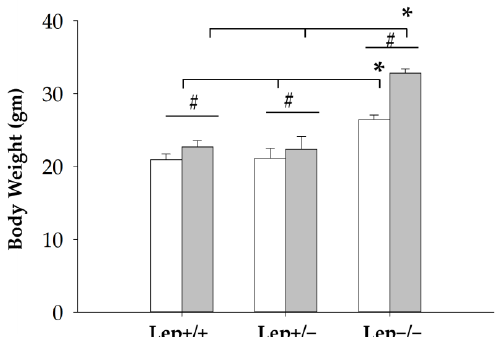
Figure 5. The body weights of mice were measured at ages of 5 (white bar) and 6 (gray bar) weeks. Data represented mean ± SEM of each group: Lep+/+ (n = 7), Lep+/ − (n = 5), and Lep − / − (n = 4). Data were analyzed with two-way ANOVA followed by all pairwise multiple comparison Holm-Sidak post hoc test. Statistical significance set at p < 0.05; # indicates the statistical significance of body weight within each genotype between weeks of 5 and 6. * indicates the statistical significance of body weight within each week among three different, respectively.